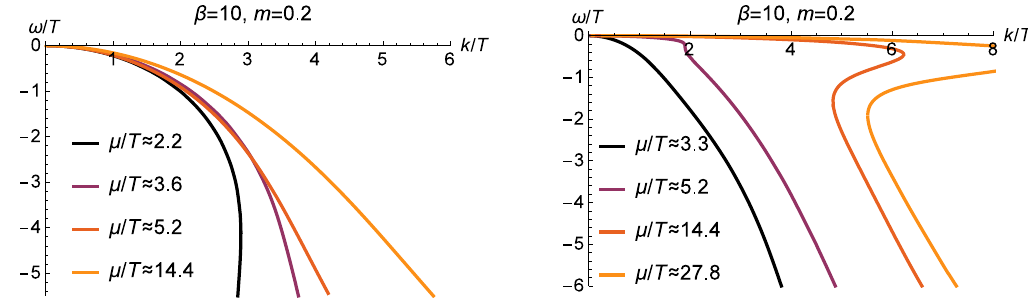
Figure 16 . The di(cid:11)usion QNM (left) and CM (right) at (cid:12) = 10 and m = 0 : 2.